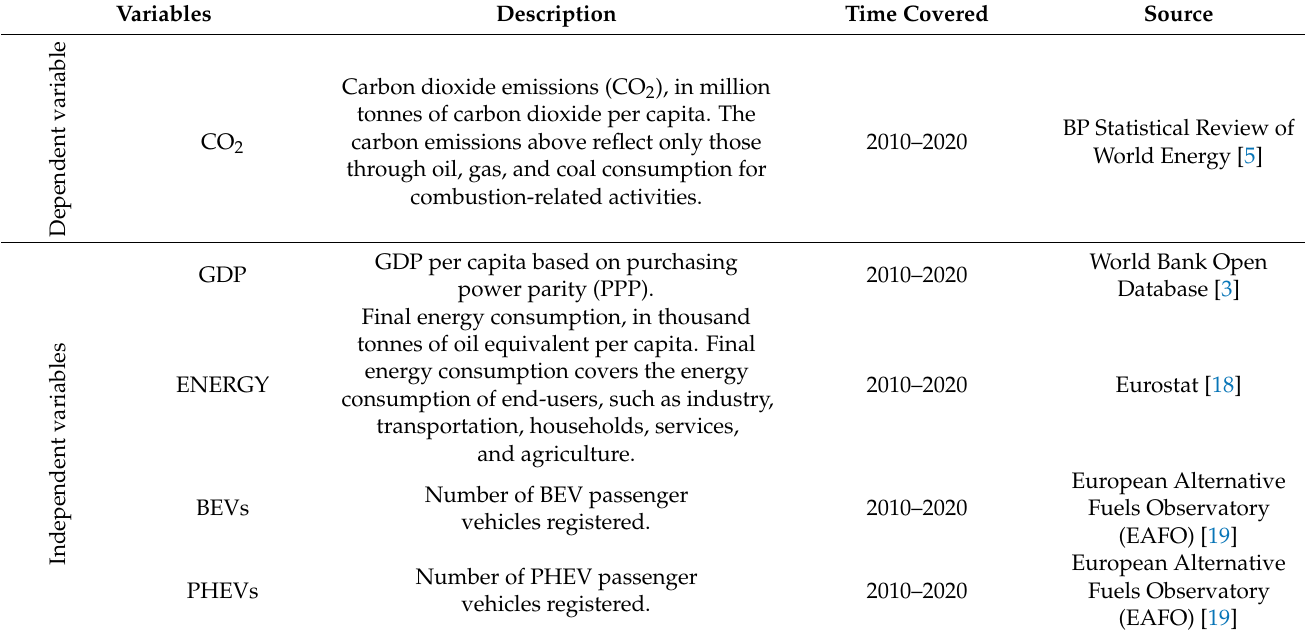
Table 1. Description of variables.